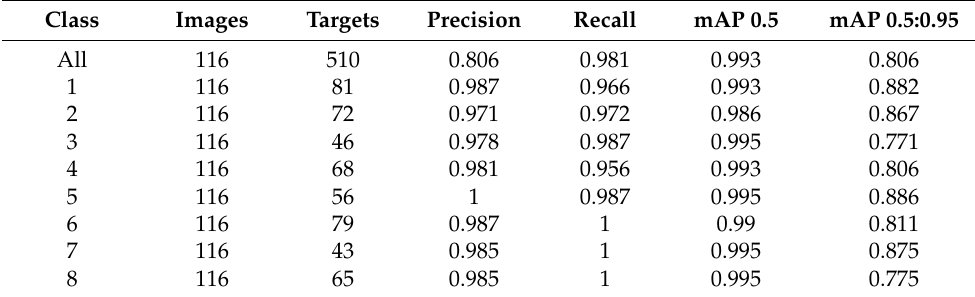
Table 5. Performance of the model YOLOv5m for first dataset (582 images). Class Images